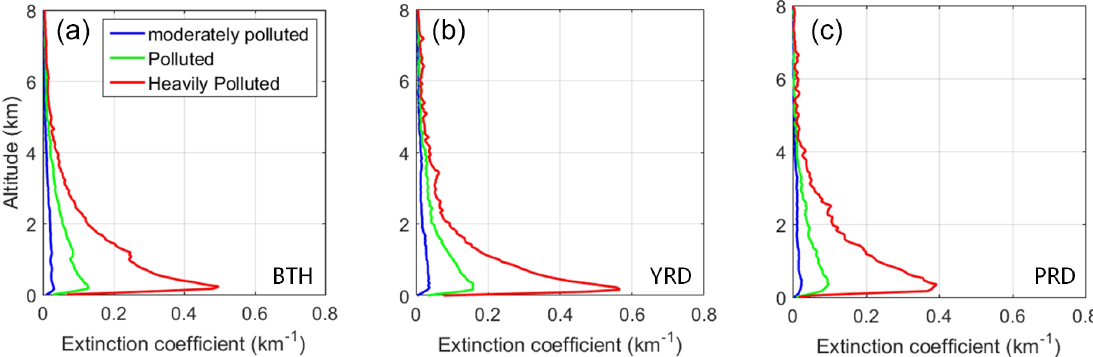
Figure 5. Aerosol extinction coefficient profiles, averaged over the years 2007–2020, over the BTH (a) , YRD (b) and PRD (c) , grouped in different CALIOP AOD ranges for moderately polluted, polluted and heavily polluted conditions (see